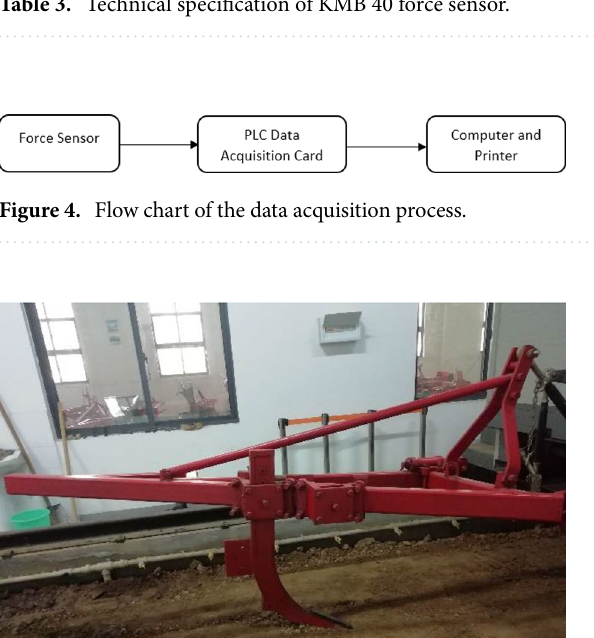
Table 3. Technical specification of KMB 40 force sensor.